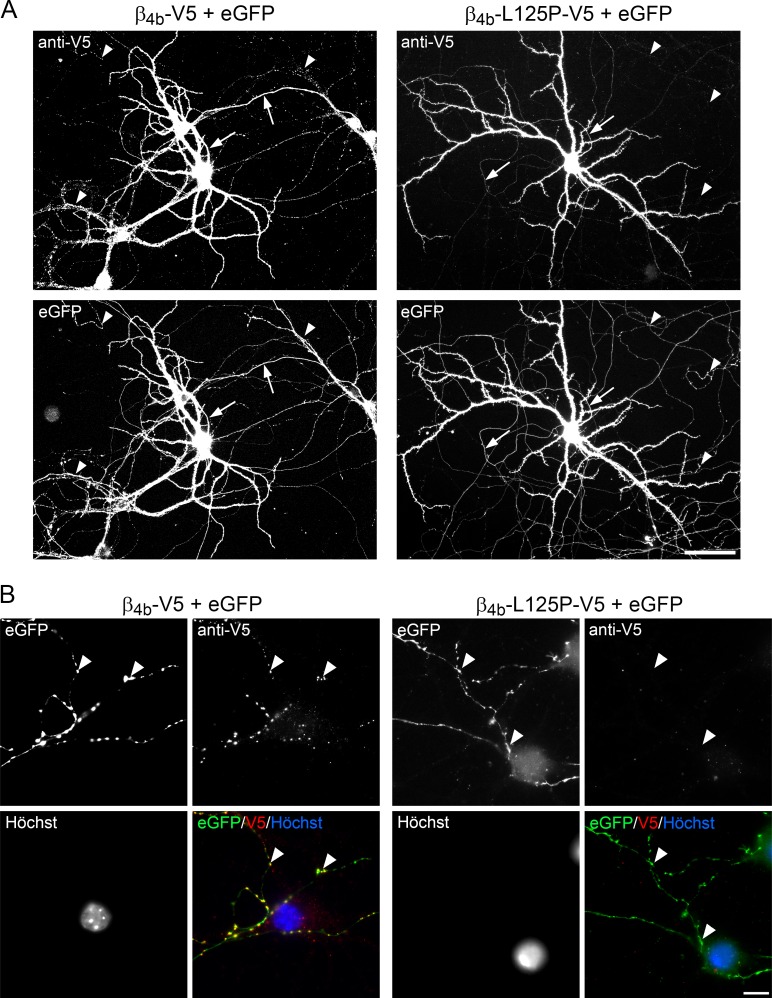
Axonal and synaptic targeting of the β4b-L125P mutant fails in primary hippocampal neurons.Cultured hippocampal neurons were transfected with eGFP and β4b-V5 or β4b-L125P-V5 on DIV6 and immunolabled with anti-V5 on DIV34. Nuclei were labeled with Hoechst dye (blue). (A) Overview images of the dendritic and axonal arborization (eGFP) and anti-V5 labeling (anti-V5) of neurons expressing β4b-V5 (left panel) or β4b-L125P-V5 (right panel). Arrows indicate segments of the proximal axons and arrowheads indicate exemplary axonal contact points with neighboring non-transfected cells typical for presynaptic boutons. (B) Presynaptic boutons were identified as eGFP-filled axonal varicosities contacting postsynaptic untransfected cell somata or dendrites. β4b-V5 accumulated in presynaptic boutons of transfected hippocampal neurons (arrowheads, left panel). In contrast, a distal axonal localization of β4b-L125P-V5 was missing and β4b-L125P-V5 failed to be incorporated in presynaptic boutons (arrowheads, right panel). Scale bars, 20 μm (A) and 10 μm (B). Representative images of three independent experiments are shown (see Results for statistics).